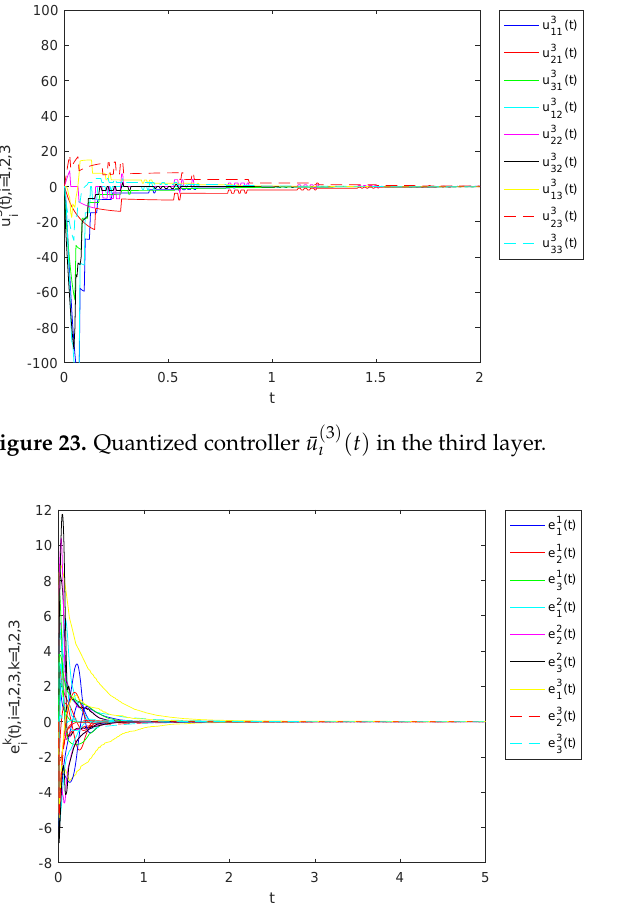
Figure 24. Synchronization error without inter-layer couplings under Controller (17).